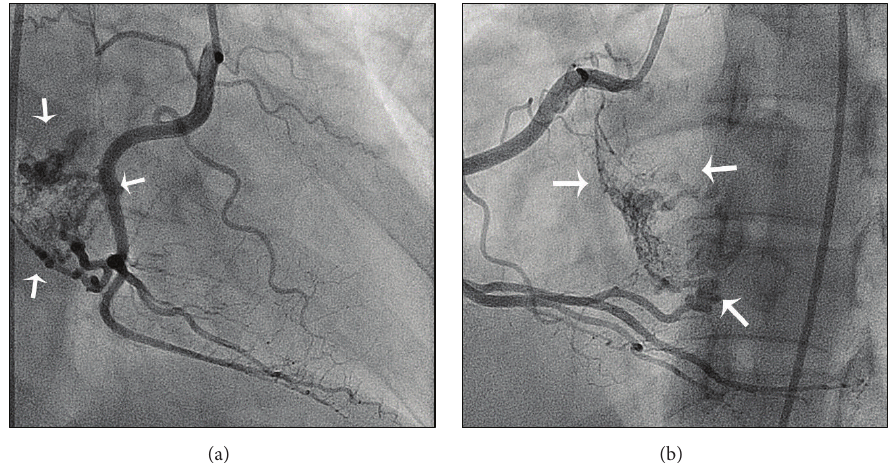
Figure 1: Selective right coronarography showing the large amount of contrast media enhancing the tumoral mass (white arrows). (a) Right anterior oblique projection; (b) left anterior oblique projection.